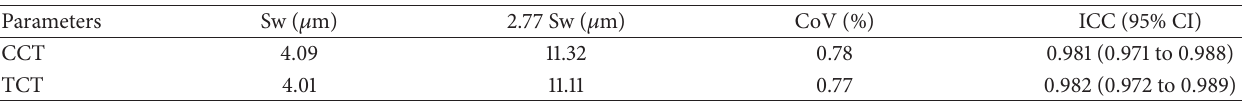
Table 2: Interoperator reproducibility of central corneal thickness (CCT) and the thinnest corneal thickness (TCT) readings by the Scheimpflug-Placido topographic modeling system (TMS-5).